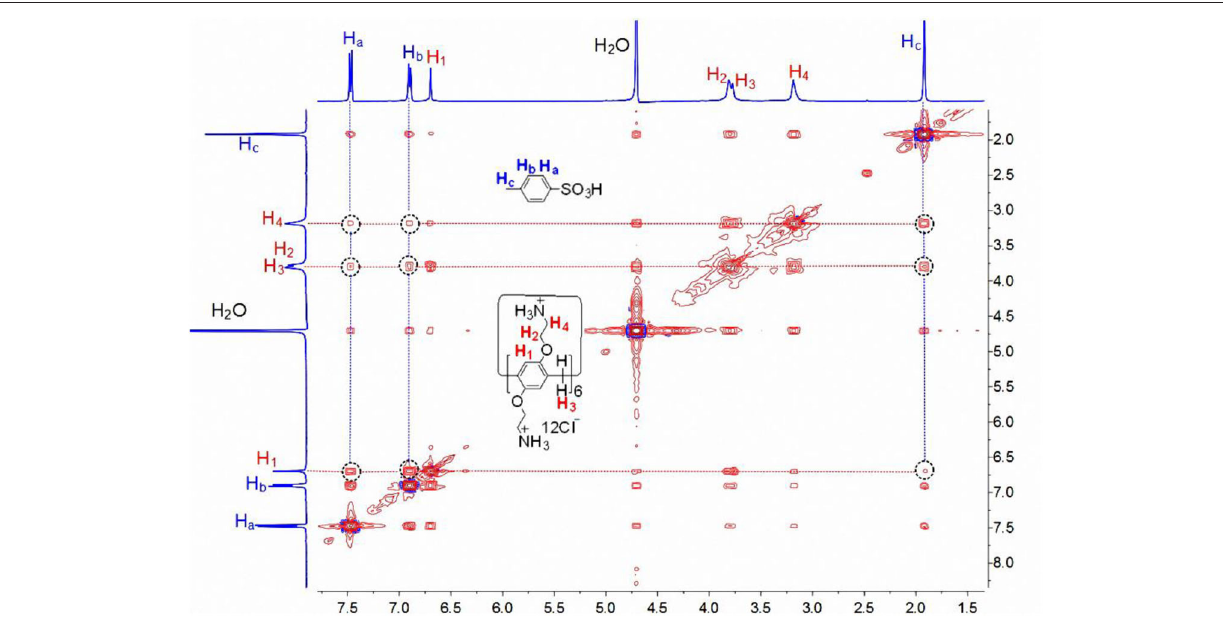
FIGURE 2 | 2D NOESY NMR (400 MHz, D 2 O, 298K, mixing time = 300ms) spectrum of a solution of CP6 (2.00mM) and p-TSA